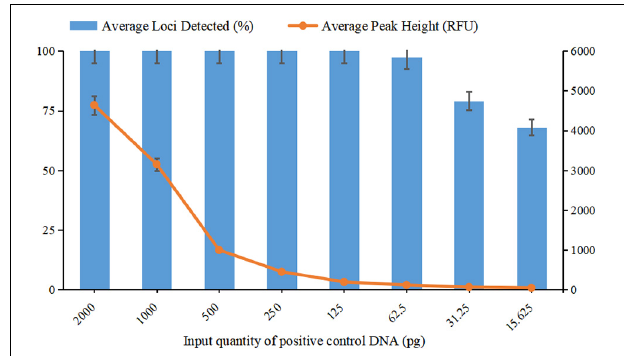
FIGURE 5 | Sensitivity testing of template DNA ranging from 15.625 pg to 2 ng. The average percentage of loci detected was against the DNA input quantity. The left Y -axis represents the average percentage of loci detected, and the right Y -axis represents the average peak height. Error bars show the SDs between three replicates.